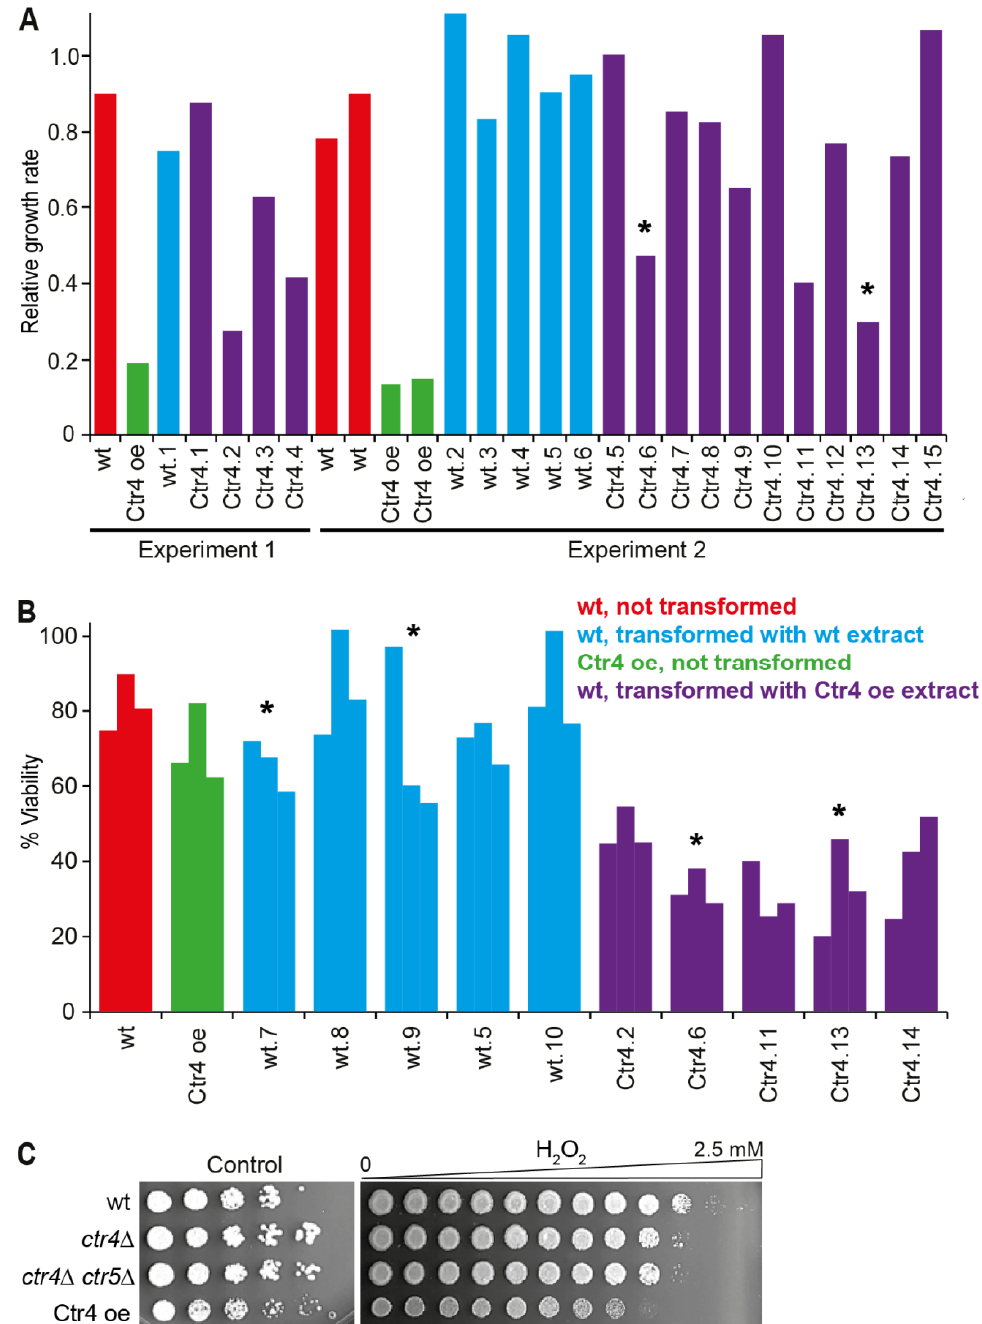
FIGURE 4: Ctr4 overexpression leads to H 2 O 2 sensitivity which is transmissible by protein transformation. (A) Left, Experiment 1: wild-type cells were transformed with a cell-free extract from wild-type (wt.1) and Ctr4 overexpressing cells (Ctr4.1-Ctr4.4). For all strains, the ratios of maximum growth rate in liquid medium with 1 mM H 2 O 2, relative to maximum growth rate in untreated medium, were determined in a Biolector microfermentor. Data for control wt and Ctr4 overexpression (Ctr4 oe) cells are also shown. Right, Experiment 2: as Experiment 1, but showing additional, independent transformants with extracts from wild-type (wt.2-wt.6) and Ctr4 overexpressing cells (Ctr4.5-Ctr4.15). Data for two independent wild-type control (wt) and two independent Ctr4 overexpression (Ctr4 oe) cells are also shown. Strains whose extracts were used for the protein transformations in the meiosis experiments (Figure 5) are indicated with asterisks. (B) Wild-type cells were transformed with extracts from wild-type (wt.5, wt.7-wt.10) or Ctr4 overexpressing cells (Ctr4.2. Ctr4.6, Ctr4.11, Ctr4.13, Ctr4.14). Cell viability after treatment with 0.5 mM H 2 O 2 relative to untreated cells was determined for the transformed strains and for control wt and Ctr4 overexpression (Ctr4 oe) strains. Strains whose extracts were used for the protein transformations in the meiosis experiments (Figure 5) are indicated with asterisks. (C) Wild-type (wt), ctr4 Δ single and ctr4 Δ ctr5 Δ double mutants, and Ctr4 overexpressing cells were spotted in serial dilutions on EMM plates (Control, left) or in equal quantities onto EMM plates containing a gradient of 0 to 2.5 mM H 2 O 2